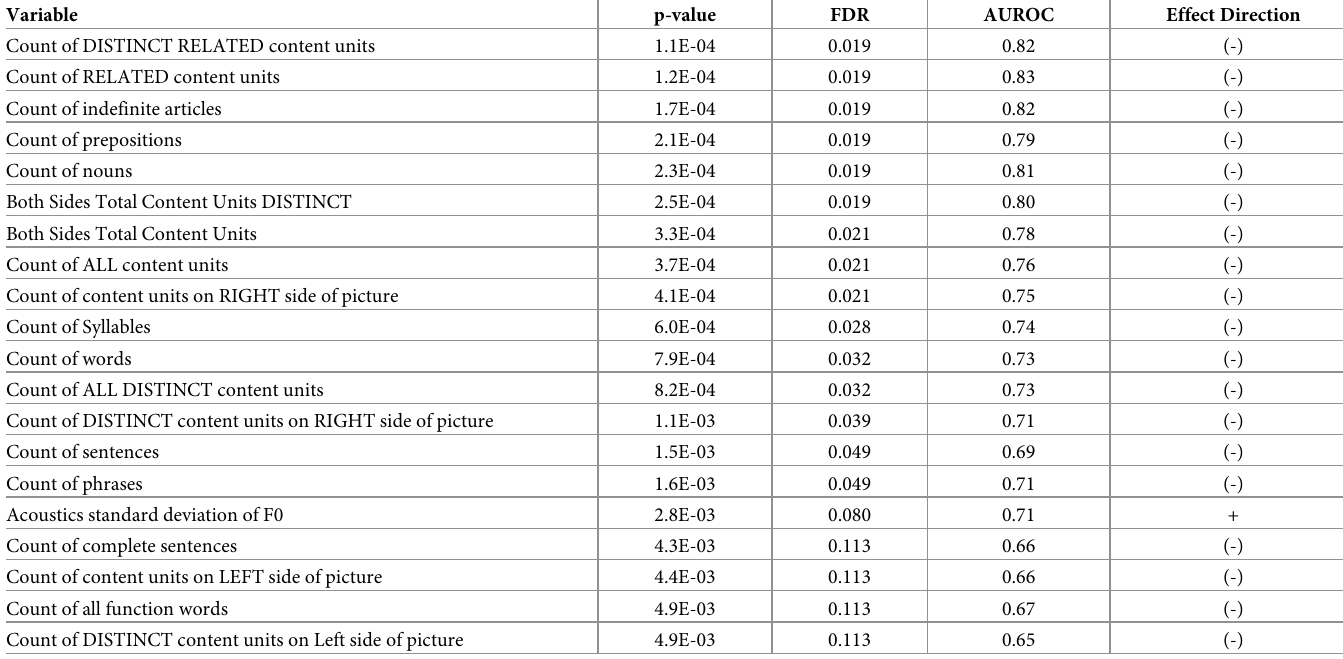
Table 2. Association of features derived from picture description recordings or transcripts with diagnosis of aMCI or